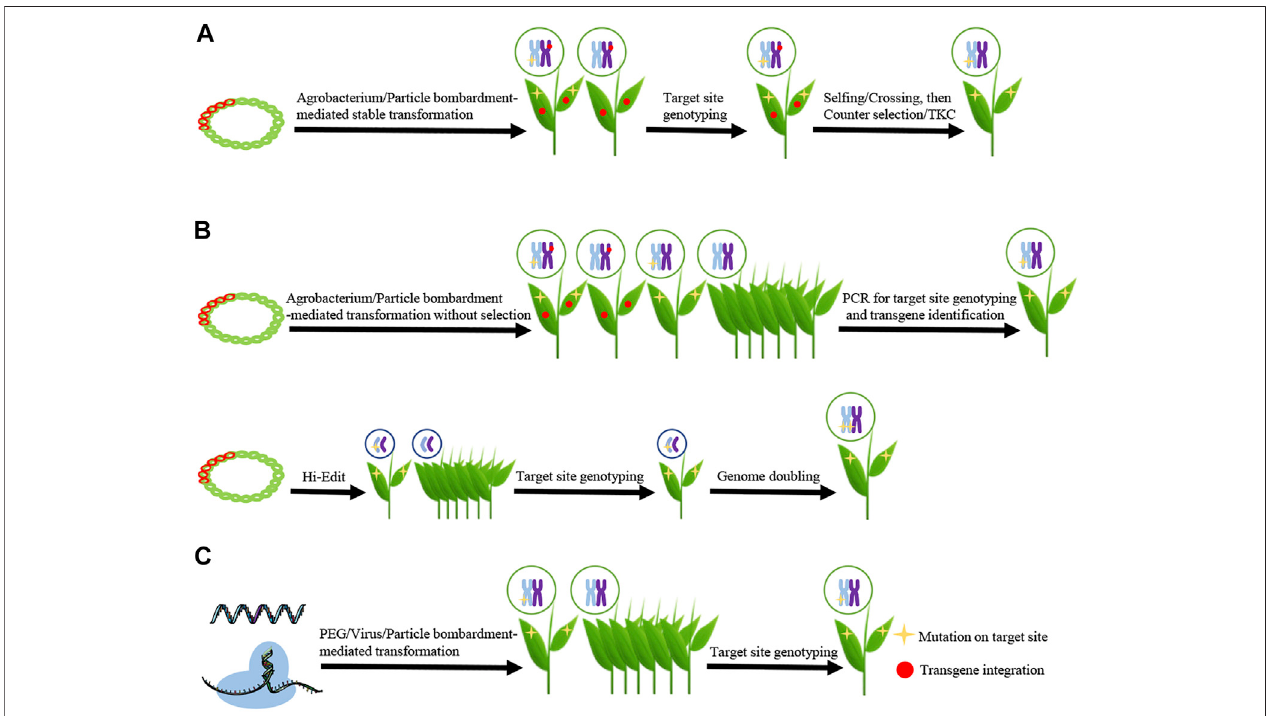
FIGURE 1 | Schematics showing the main strategies for isolating transgene-free and genome-edited plants (A) Eliminating transgenic sequence through genetic segregation.CRISPR/CasDNA(represented byred double helix)isdelivered intoplant cellsusing Agrobacteriumtumefaciens orparticlebombardment. Thetransgenic plants are isolated, and then genome edited plants are selected through target site genotyping. The transgene-free and genome edited plants are isolated from progenies of transgenic genome edited plants which is facilitated by counter-selection or transgene killer CRISPR (TKC) (B) Transiently expressing the editor from DNA vectors. CRISPR/Cas DNA could be delivered into plant cells using Agrobacterium tumefaciens /particle bombardment (upper schematic) or Hi-Edit (lower schematic). For the strategy using agrobacterium/particle bombardment-mediated transformation, transgene-free and genome edited plants are isolated from all the regenerated seedlings by PCR for target site genotyping and transgene identi fi cation. For the strategy using HI-Edit, the haploid progenies are selected and genotyped. The genome edited haploid plants are genome doubled to produce the transgene-free and genome edited doubled haploid line (C) Delivering editors in a DNA- independent manner. CRISPR/Cas9 RNA or Ribonucleoproteins (RNPs) are delivered into plant cells by polyethylene glycol (PEG)-, virus- or particle bombardment- mediatedtransformation,andthentransgene-freeandgenomeeditedplantsareisolatedfromalltheregeneratedseedlingsbytargetsitegenotyping.Mutationontarget site is represented by yellow star and transgene integration by red